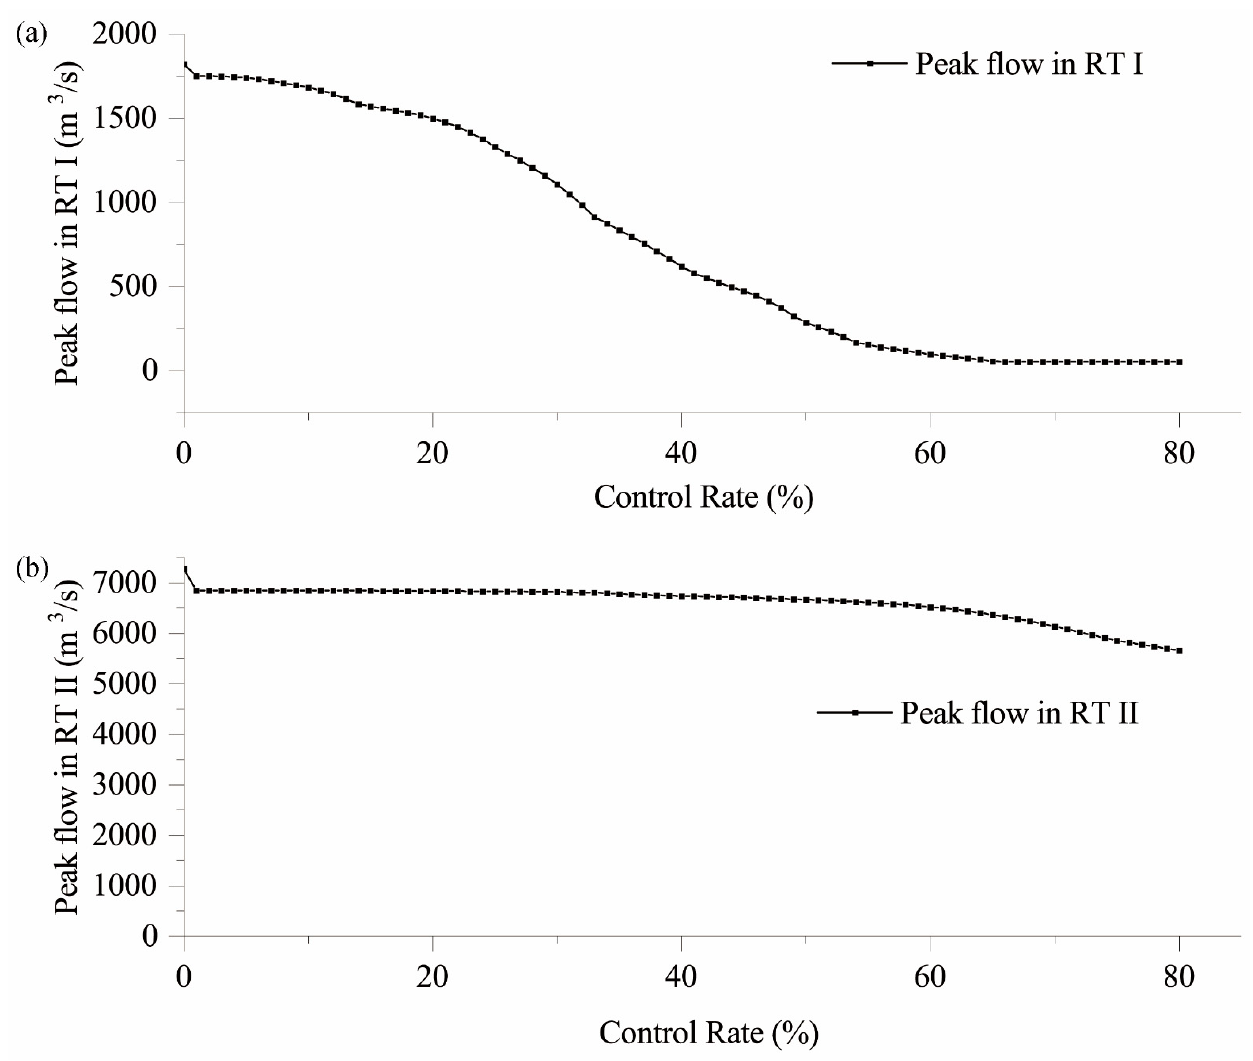
Figure 11. The relationship between the control point’s peak flow and the detention facilities’ control rate in RT I ( a ) and RT II ( b ).